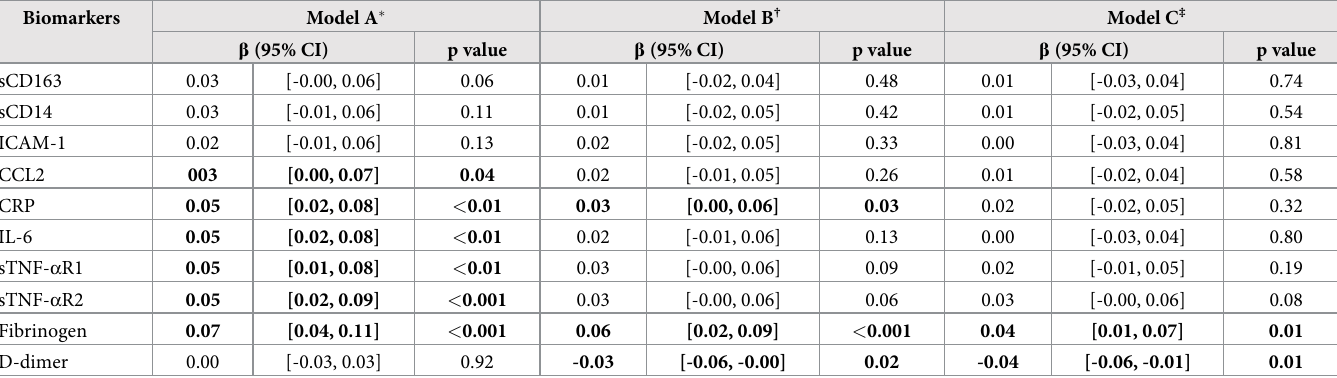
Abbreviations: sCD163, soluble cluster of differentiation 163; sCD14, soluble cluster of differentiation 14; CCL2, chemokine (C-C motif) ligand 2;